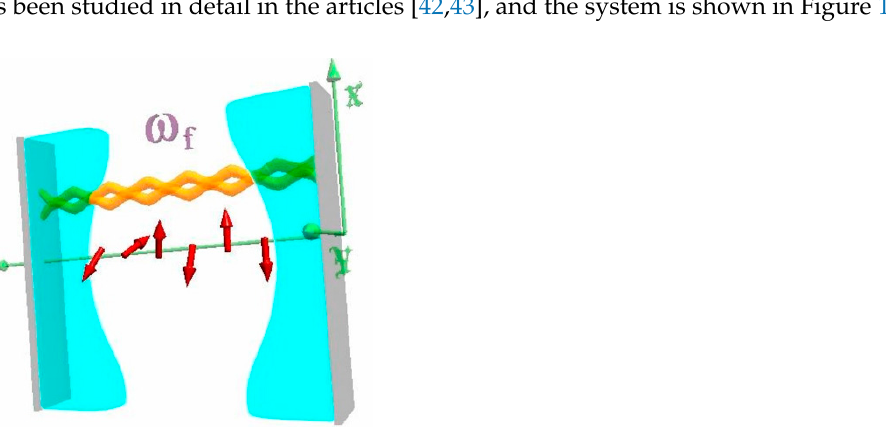
in XY spin chain interacting with a quantized electromagnetic field in a 2